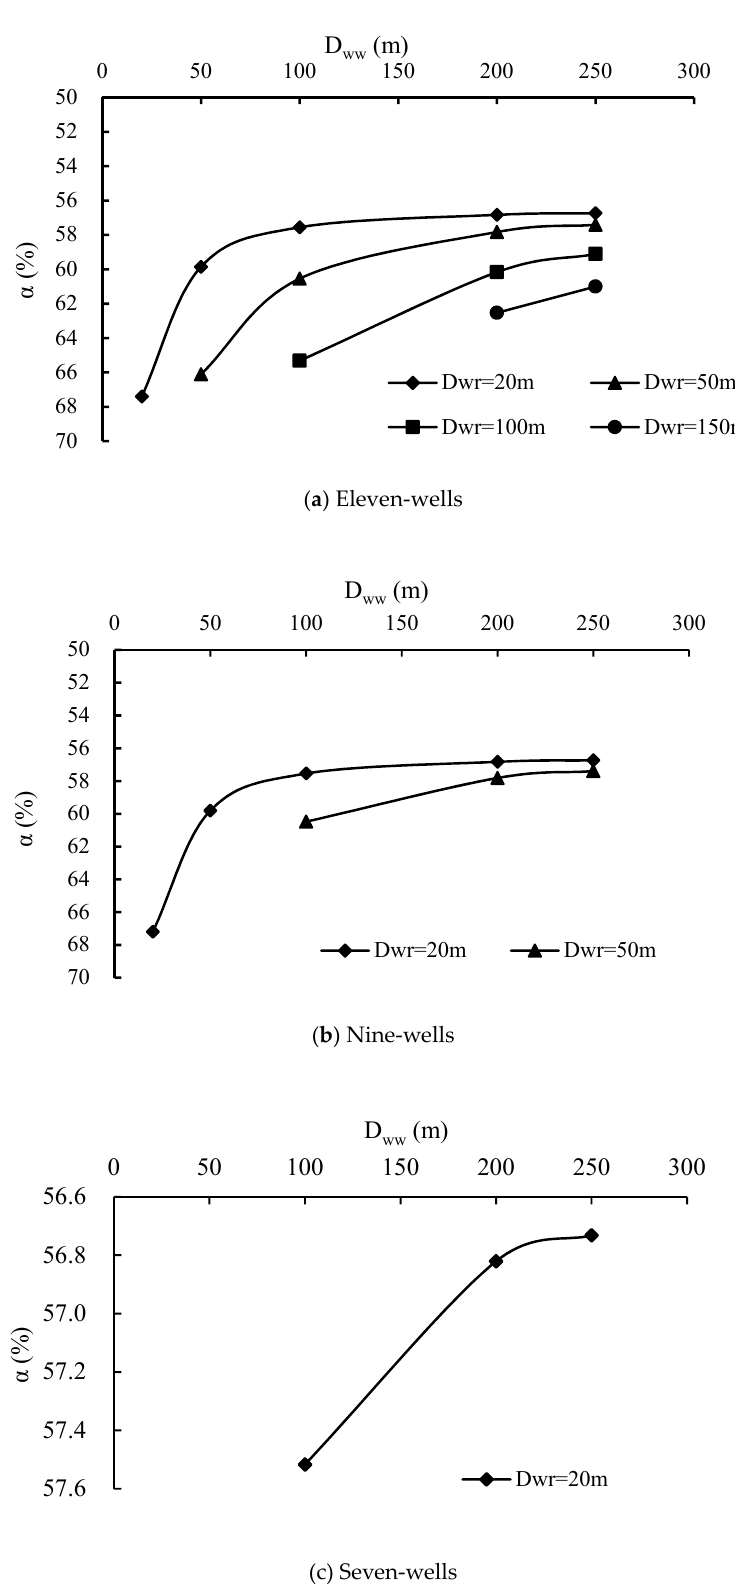
Figure 4. Relationships between D ww and α of pumping wells.